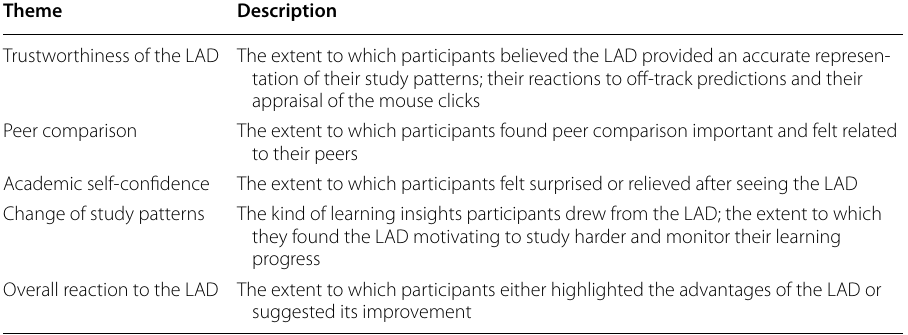
Table 1 Final coding scheme with descriptions of themes (factors) of the perceived usefulness of the LAD Theme